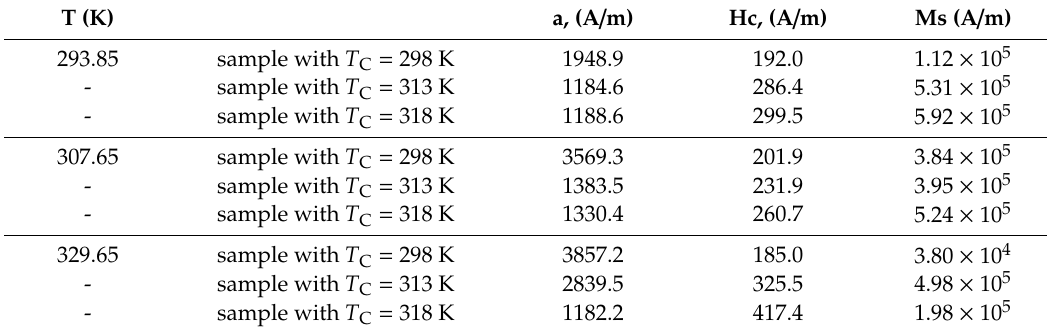
Figure 13. The measured and the modeled hysteresis curve of the composite core at T = 329.65 K. The values of model parameters for some chosen temperatures are listed in Table 4. Table 4. Values of model parameters for chosen temperature values.